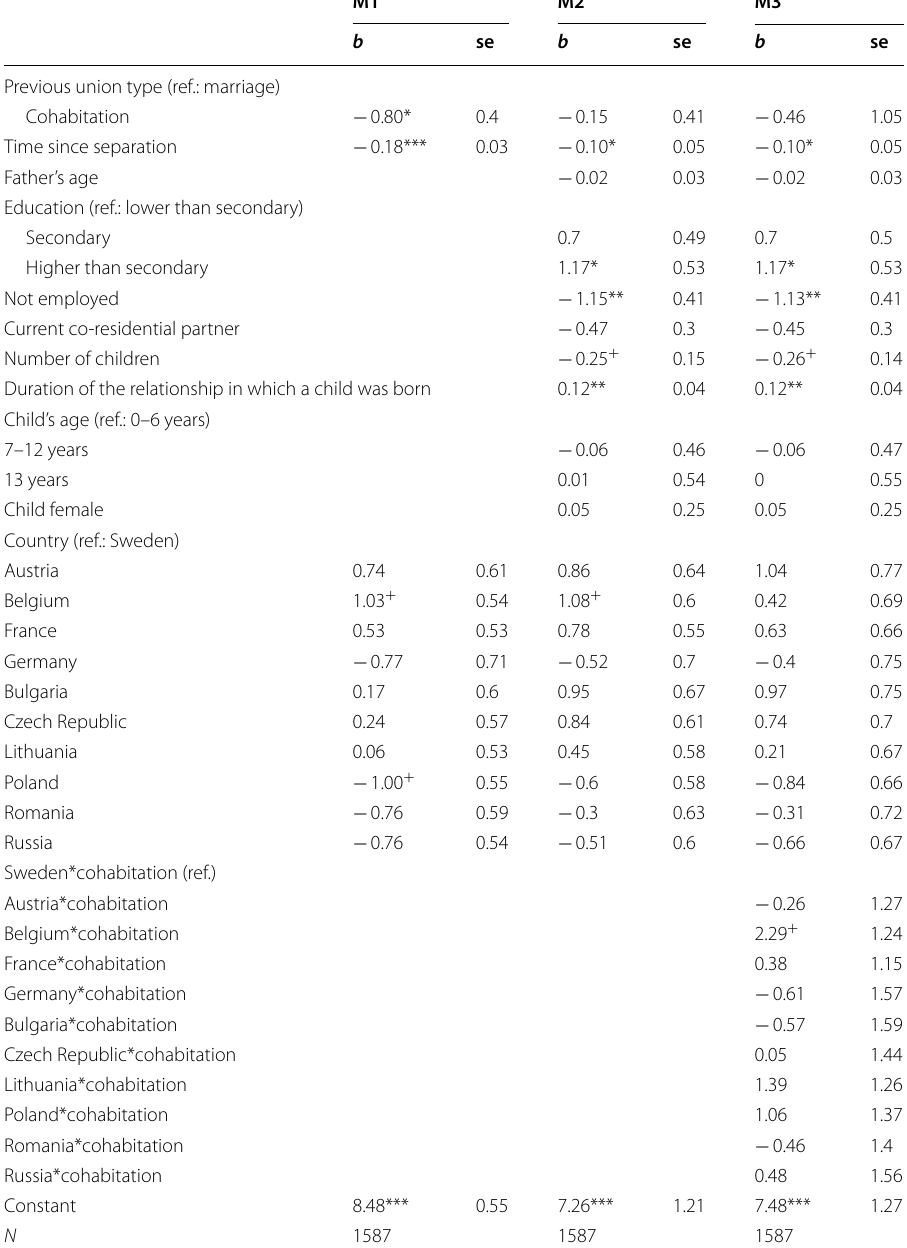
Table 4 Father’s satisfaction with quality of relation with a